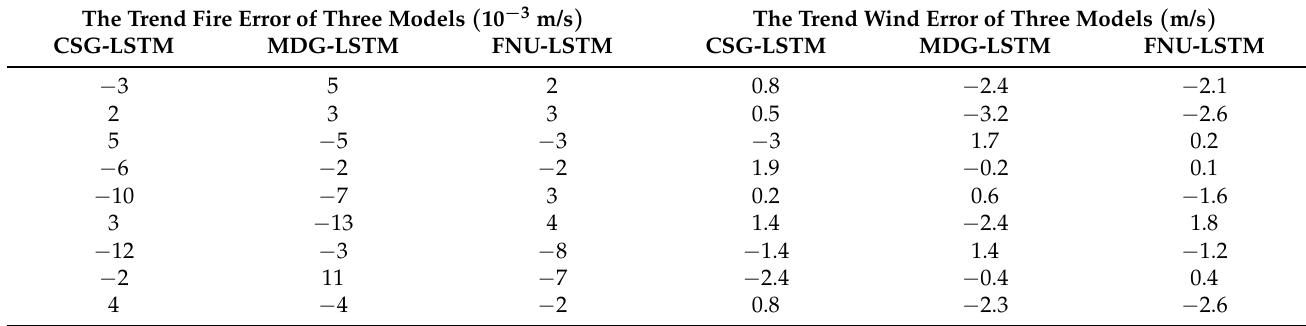
Table 5. The trend error of three models.